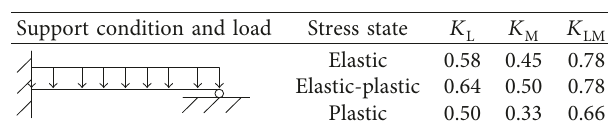
Table 1: Dynamic design factors of the cantilever support system